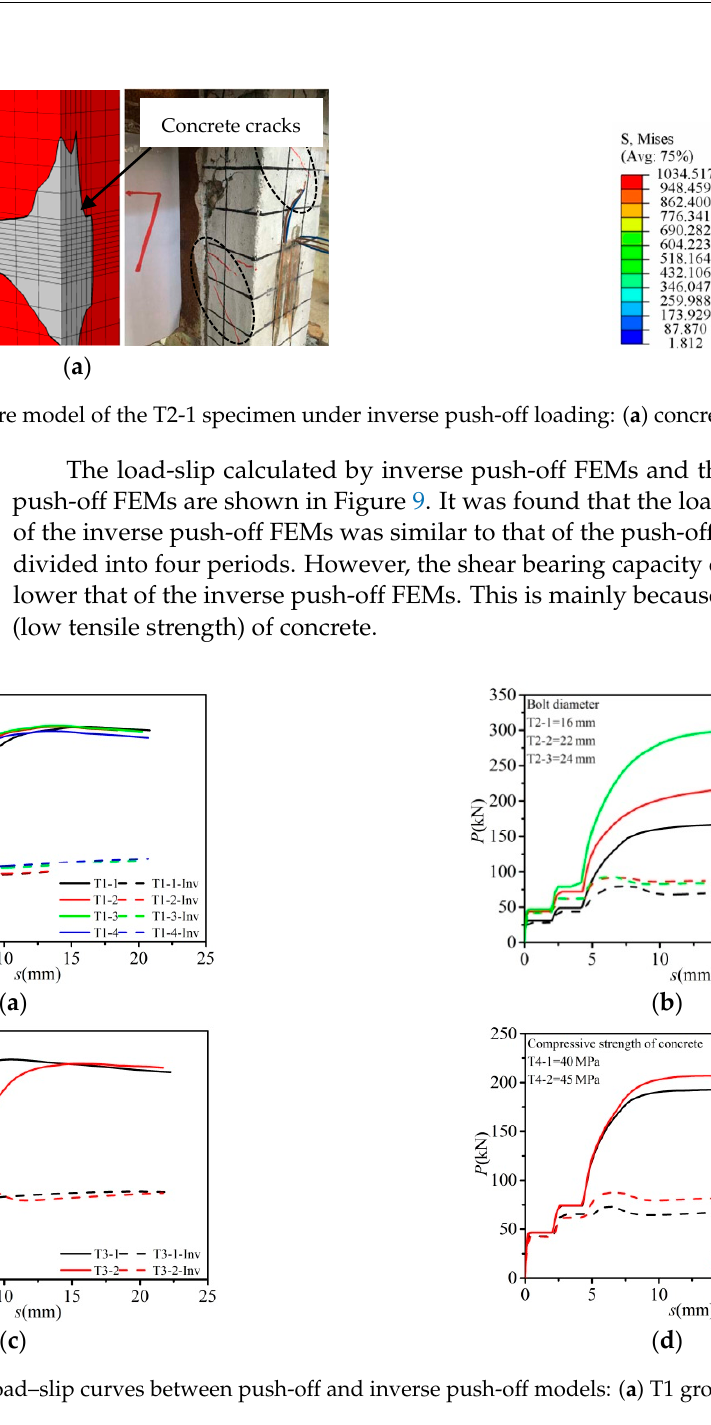
Table 3. Variables selected for parametric studies.